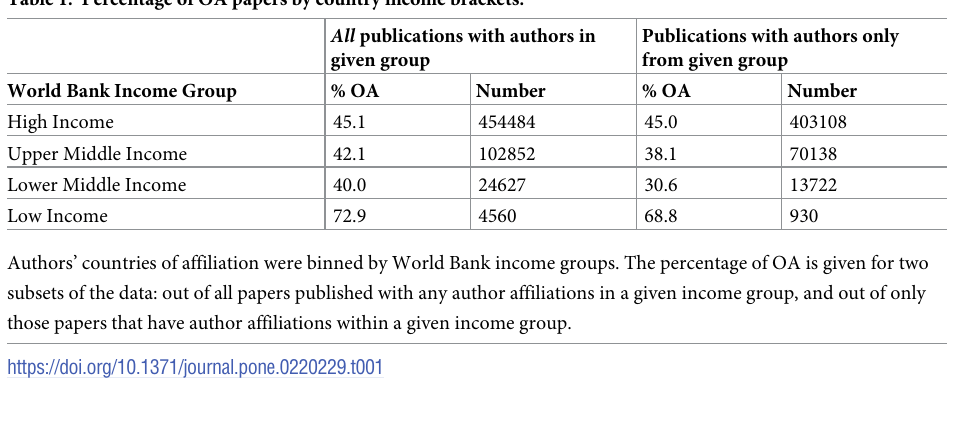
Table 1. Percentage of OA papers by country income